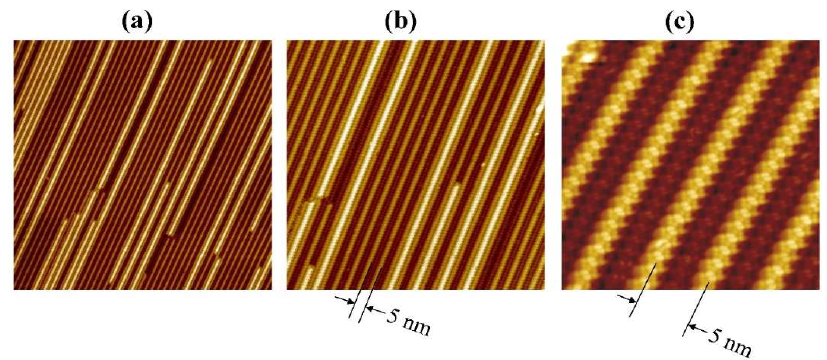
Figure 1. Scanning tunneling microscope (STM) topographic images of the atomically clean Si(110)-16 × 2 surface taken at different magnifications: ( a ) 250 × 250 nm 2 , ( b ) 125 × 125 nm 2 , and ( c ) 25 × 25 nm 2 . All images were obtained at V b = 1.5 V and I t = 0.3 nA.